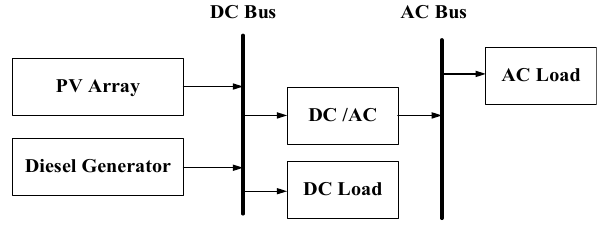
Figure 5. Block diagram of autonomous hybrid PV/diesel generator system. Table 2. Component parts and